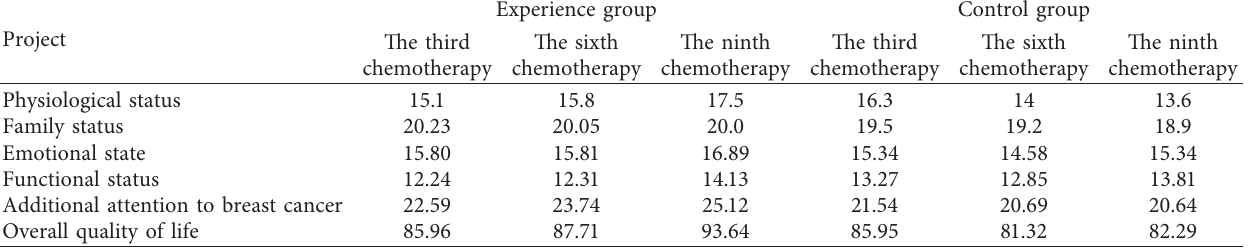
Emotional state